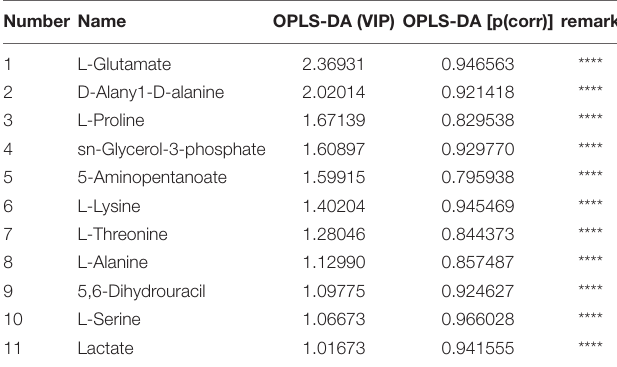
TABLE 1 | Identified metabolic